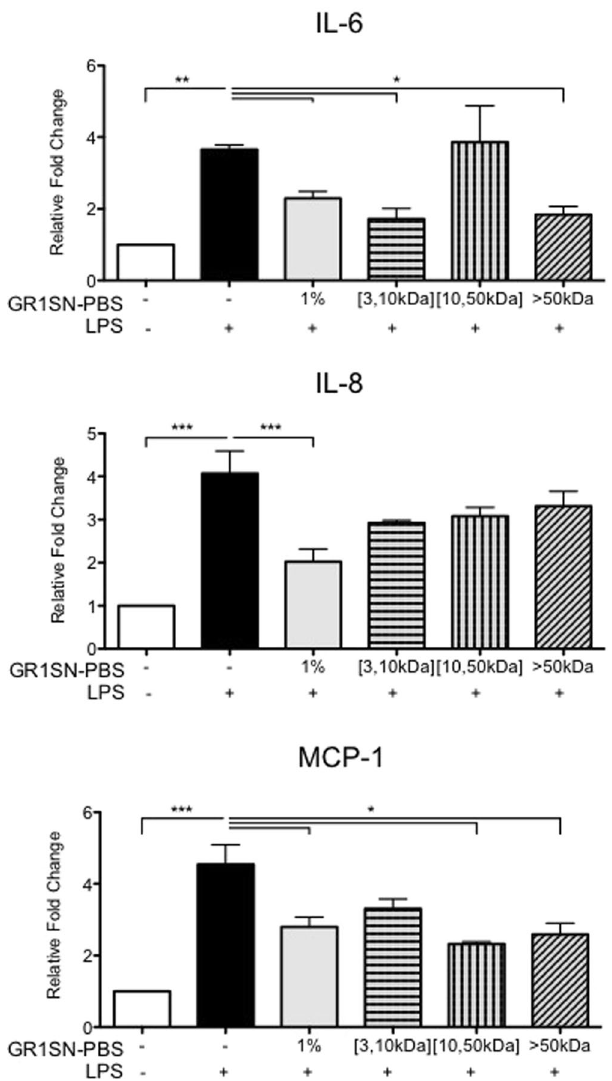
Figure 8. Effect of hTERT-HM pre-treatment with various GR1SN-PBS size fractions on LPS-induced cytokine secretions. hTERT-HM cells were pre-treated with non-modified GR1SN-PBS (solid grey bar, “1%”), or with size-fractioned GR1SN-PBS (striped bars) 16 hours prior to LPS stimulus (100 ng/mL). GR1SN-PBS was separated into fractions between 3 and 10 kDa ([3,10 kDa]), between 10 and 50 kDa ([10,50 kDa]), or greater than 50 kDa ( > 50 kDa). Values are presented as fold change (mean ± SEM) relative to untreated control (white bars). Statistical significance was determined by One-way ANOVA followed by Dunnett’s post-test relative to LPS stimulus (solid black bars). * P < 0.05; ** P < 0.01; *** P < 0.001 (n =